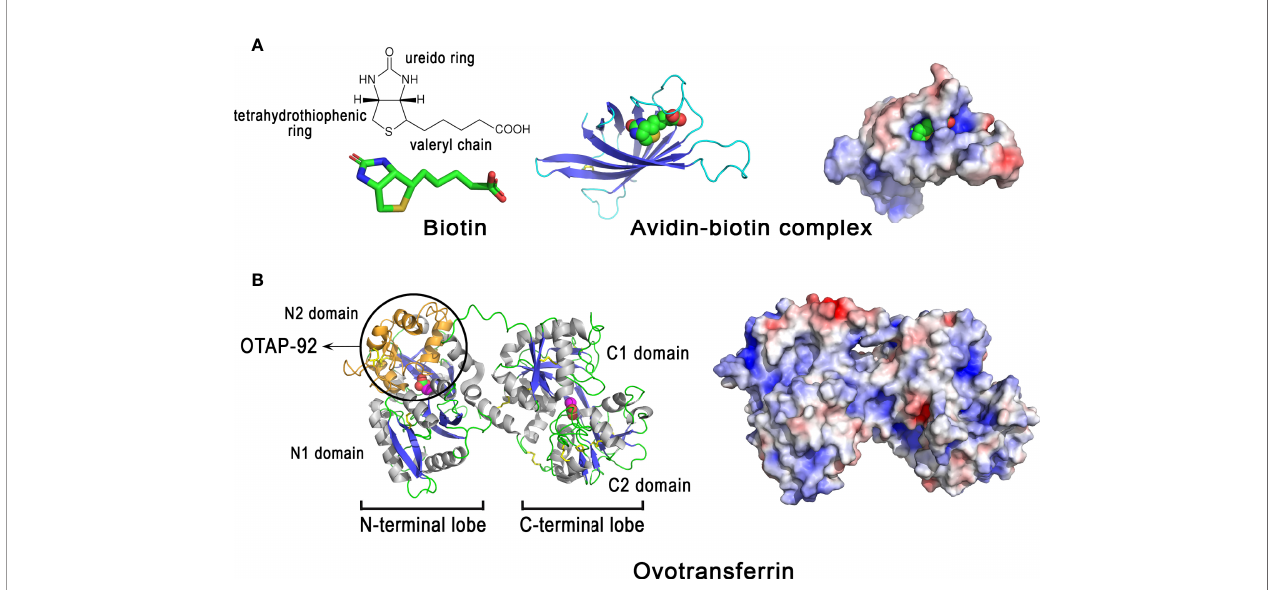
FIGURE 8 | 3D structure of egg proteins with chelating activities: avidin and ovotransferrin. 3D structure of chicken avidin (A) and chicken ovotransferrin (B). The left panels correspond to the cartoon representation of 3D structure while the right panels illustrate the color-coded electrostatic potential molecular surface. Color scheme ranges from red (negatively charged regions) to deep blue (positively charged regions). Avidin (A) is complexed to the vitamin biotin through numerous interactions including H-bonds and hydrophobic interactions. Ovotransferrin (B) possesses two lobes, each containing two domains. Each lobe binds a Fe 3+ ion and a carbonate ion. Location of the antibacterial peptide OTAP-92 is also shown. The fi gure was prepared using Pymol software (48) and APBS (Adaptive Poisson-Boltzmann Solver) plugin (49) for electrostatic calculations using atomic coordinates of 2AVI and 1N04 PDB fi le for avidin-biotin complex and ovotransferrin,